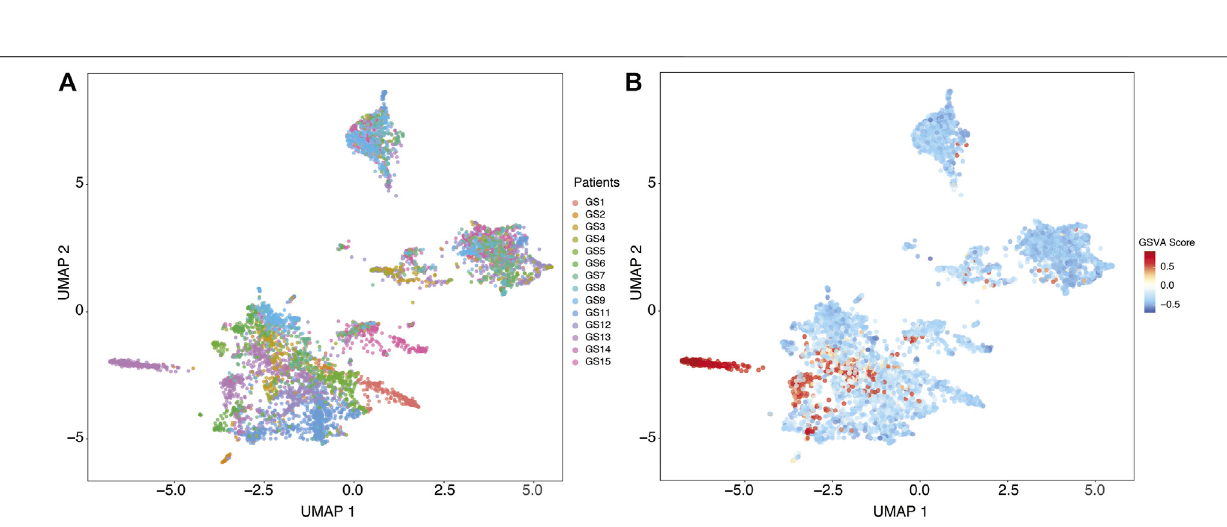
FIGURE 4 |(A) Uniform Manifold Approximation and Projection (UMAP) of Pearson residuals across13 patients. (B) GSVA enrichment scoresin all cells acrossall patients identi fi es cells with upregulation (positive GSVA scores) of the cilium genes, dominantly in cells from